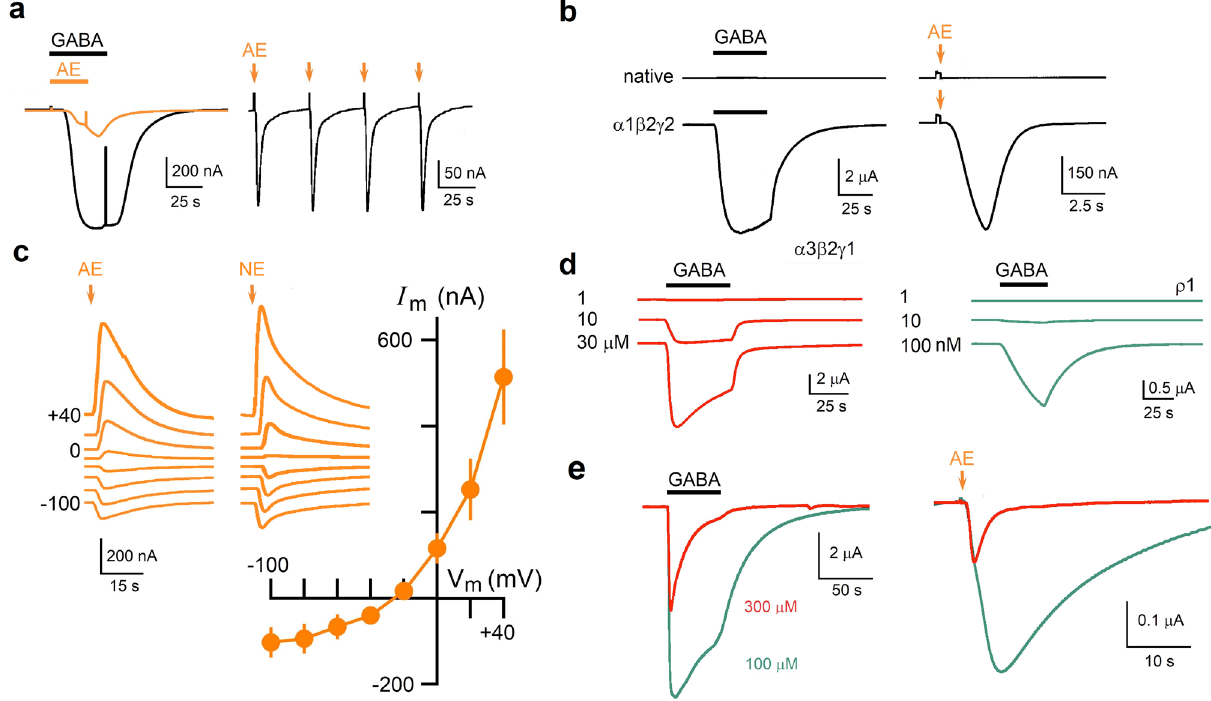
Figure 8. B. annulata venom contains an agonist of GABA A receptors. ( a ) Traces on the left illustrate inward current responses in Xenopus oocytes expressing the neuronal GABA A (α1β2γ2) receptor; cells were held at − 60 mV and superfused with either GABA (10 μM; black trace) or AE (1 mg ml −1 ; orange trace). In the trace on the right, AE was applied close to the oocyte surface using the jet delivery method, which consists of a small volume (25–75 nl) ejected from a micropipette filled with solution containing AE (0.5 mg ml −1 ), four AE-jets (orange arrows) applied successively show that current responses generated were robust and reproducible. ( b ) Top traces show that native oocytes (H 2 O-injected) were not sensitive to GABA superfusion or to AE jet-delivery (orange arrow indicates jet activation), while oocytes from the same frog expressing the neuronal GABA A receptor (bottom traces) generated robust current responses to both GABA and AE. ( c ) Traces are responses at different holding potentials from − 100 to + 40 mV elicited either by jets of AE or NE as indicated; the graph is the current–voltage relationship of the responses by AE applying the same protocol in 6 different oocytes (2 frogs); individual data points are the mean ± S.D. of the peak current response in each potential. ( d,e ) AE (and NE) affects two more GABA A receptor types expressed in oocytes, the oligodendroglial receptor α3β2γ1 (red traces) and the homomeric ρ1 receptor (green traces). Traces in ( d ) show the current response to GABA around the concentration threshold for each receptor, 1 μM for α3β2γ1 and 10 nM for the ρ1 receptor. In ( e ) the traces on the left illustrate responses elicited by a maximal concentration of GABA in oocytes expressing the α3β2γ1 receptor (in red) or the ρ1 receptor (trace in green), while the traces to the right show the response in the respective oocytes elicited by the same dose of AE. Traces are representative of results obtained in 7 oocytes from 3 different